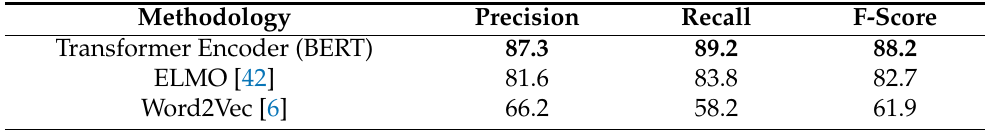
Table 5. Comparison of different evaluation methodologies in